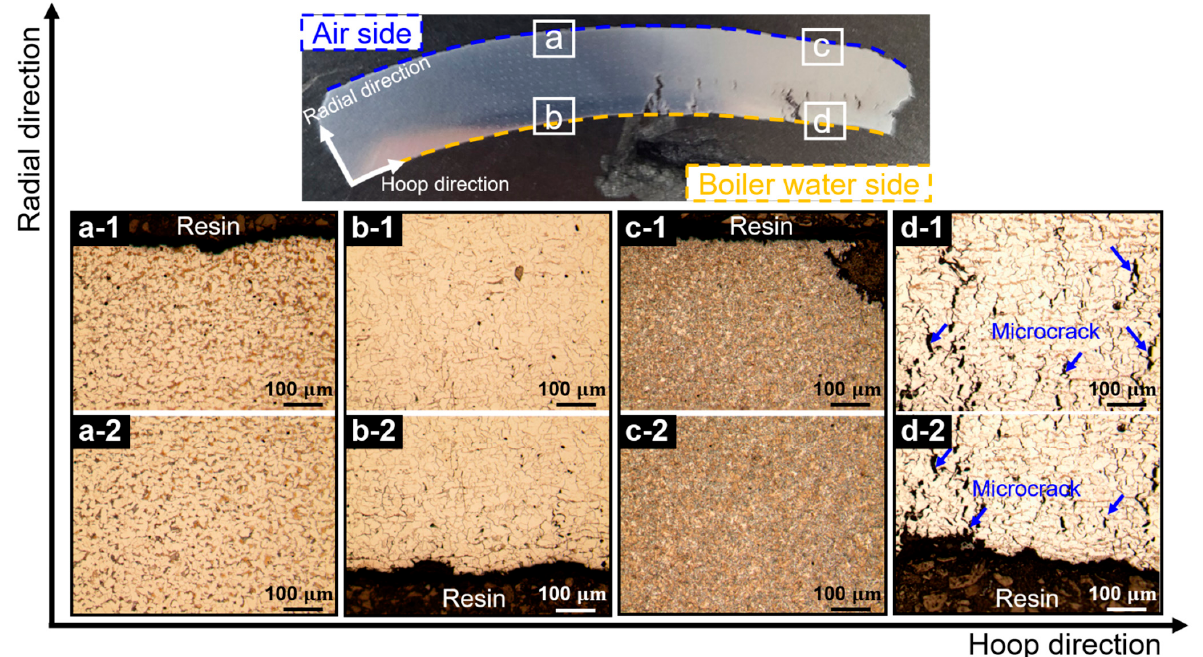
Figure 4. Microstructure analysis results of the damaged (fractured) tube: ( a-1 , a-2 ) images in the air side, ( b-1 , b-2 ) images in the boiler water side, ( c-1 , c-2) images in the air side of the overheated zone and ( d-1 , d-2 ) image in the boiler water side of the overheated zone.